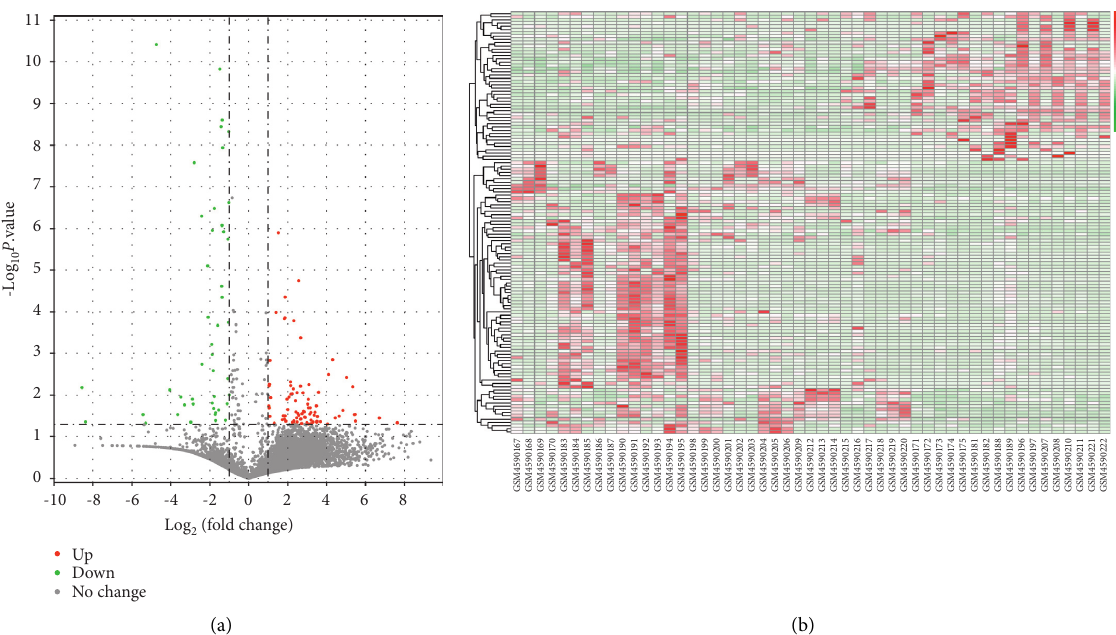
Figure 1: Volcano map and heat map of DEGs. (a) Volcano map. Green stands for downregulated DEGs, red stands for upregulated DEGs, and gray stands for no significant change genes. (b) Heat map. The expression levels of DEGs in 51